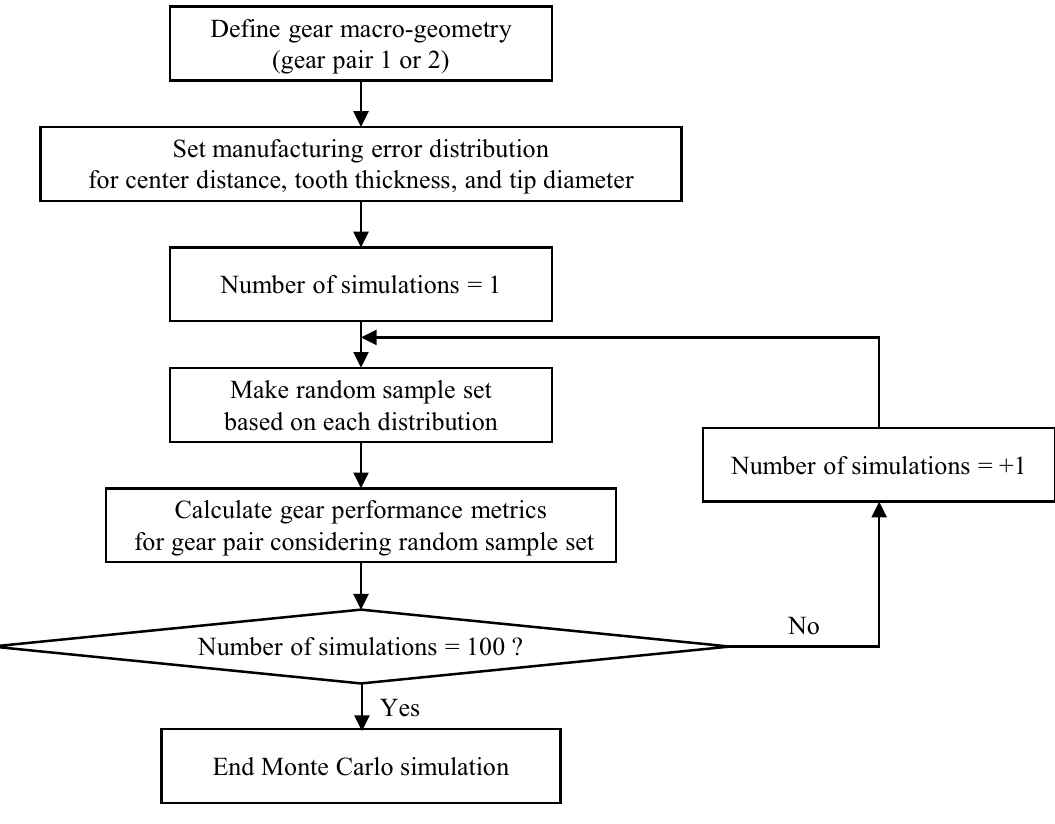
Figure 1. Flow chart of Monte Carlo simulation using 100 random sample sets for two gear